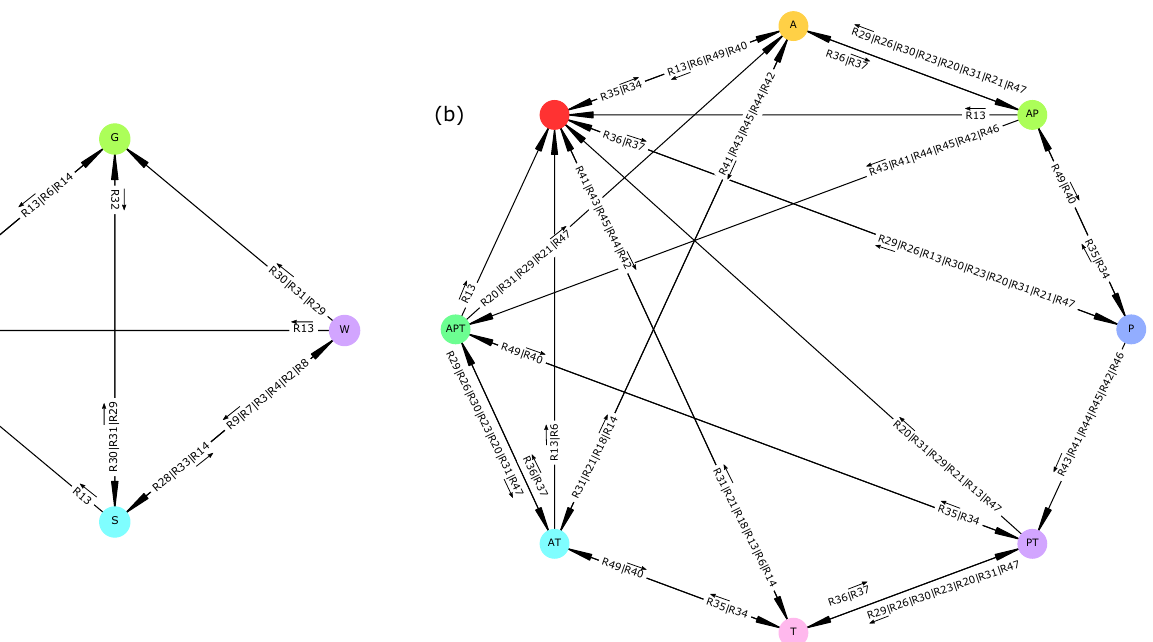
Figure A2. Vegetation and socio-economic summary graphs of the reference scenario. Summary graphs ( a , b ) are the same as Figure 2 and Figure 4, respectively, and indicate the rules involved in each transition. In ( a ) node labels indicate vegetation types as defined in Section 2.6, with B: Bare soil; G: Grassland; S: Savanna, and W: Woodland, while in ( b ) they indicate socio-economic profiles, i.e., combinations of socio-economic activities A, P, and T, with A: Agriculture; P: Pastoralism, and T: Tourism. Small arrows associated to each transition labels (rules) indicate to which transition are associated the considered group of rules (see Table A2 for details about